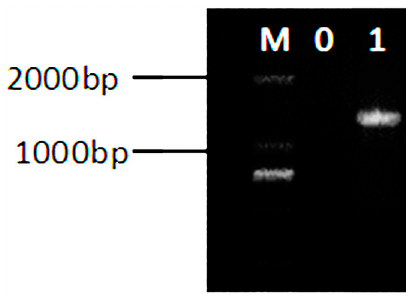
Figure 1. The 16S rDNA agarose gel electrophoresis of PCR amplified product of Lactobacillus plantarum CQPC10. M: 2000 bp DNA Ladder; 0: negative control group; 1: Lactobacillus plantarum CQPC10.